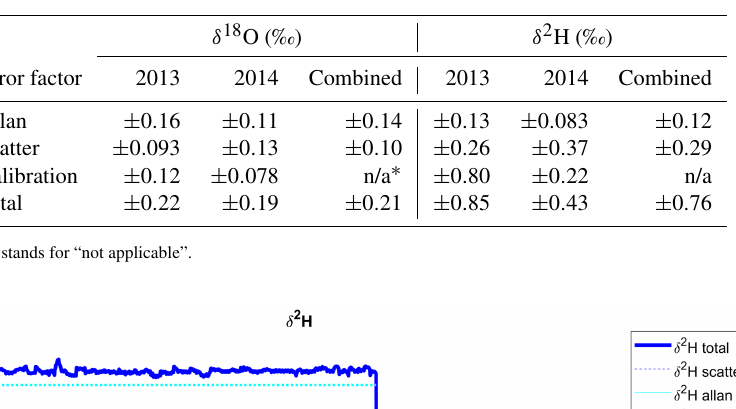
Table 2. Summary of uncertainty estimates in per mil (‰).